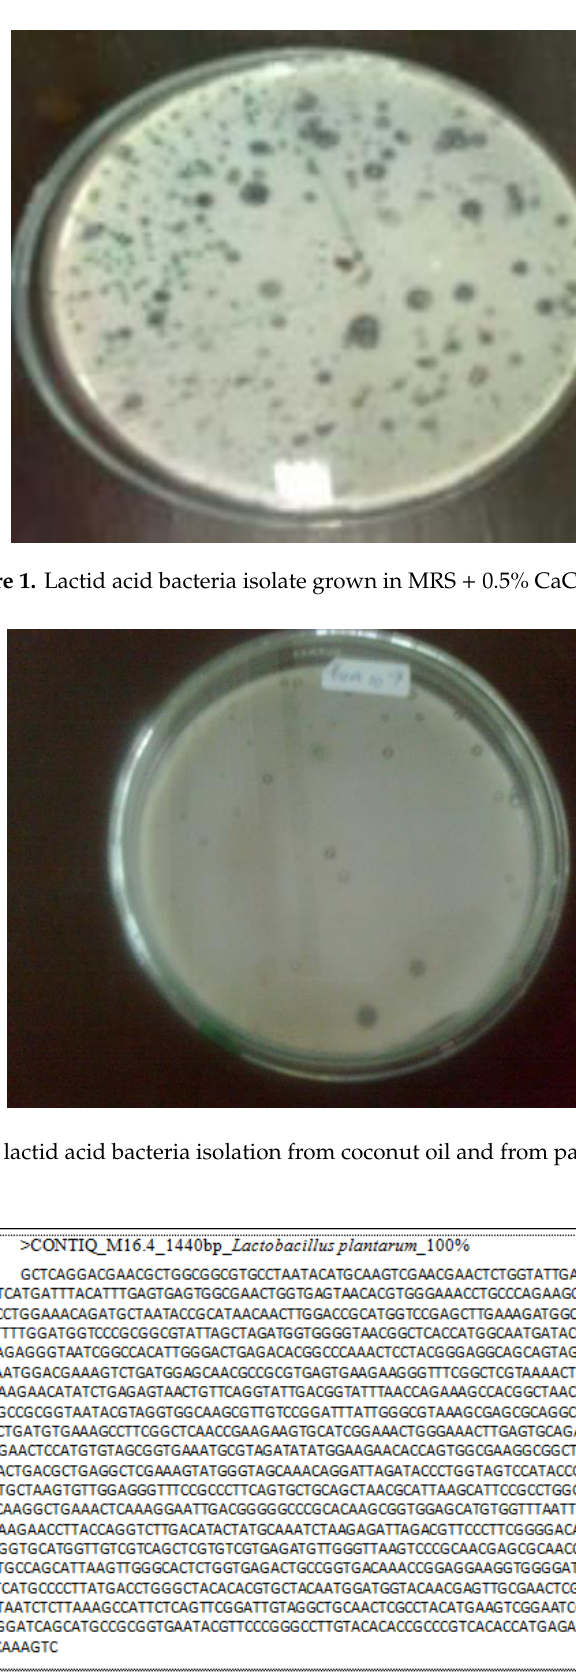
Figure 3. Lactid acid bacteria gene sequence from isolation of Lactobacillus plantarum .